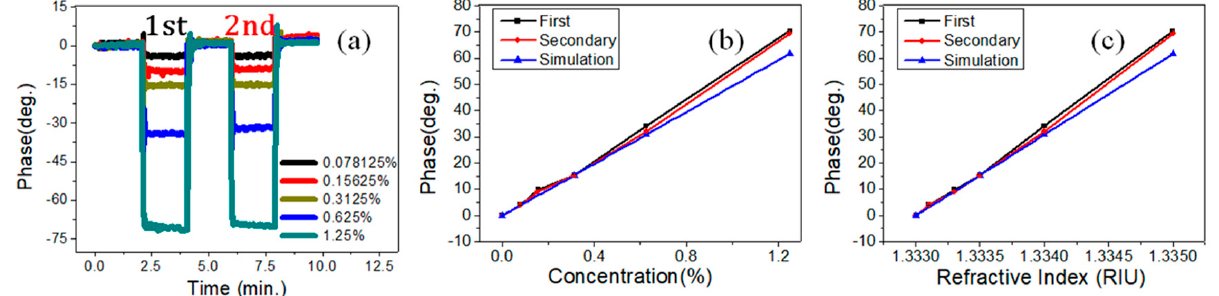
Figure 4. NaCl solution measurements with a single polyethylene terephthalate (PET) at 60° incident angle. ( a ) Phase variations by alternately exchanging the pure water and the different NaCl solution. ( b ) Phase versus NaCl concentration. ( c ) Phase versus the refractive index.